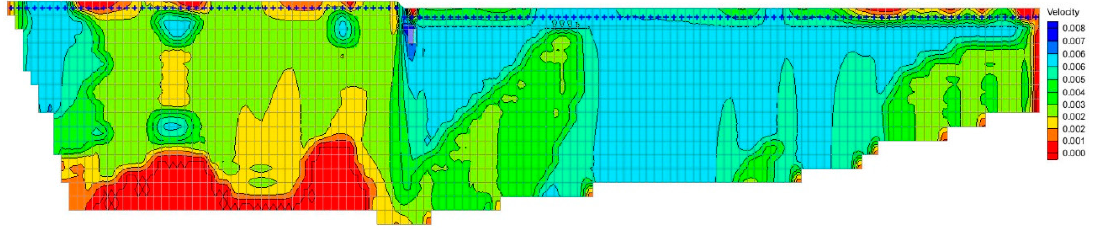
Figure 7. The average velocity in Profile 3.